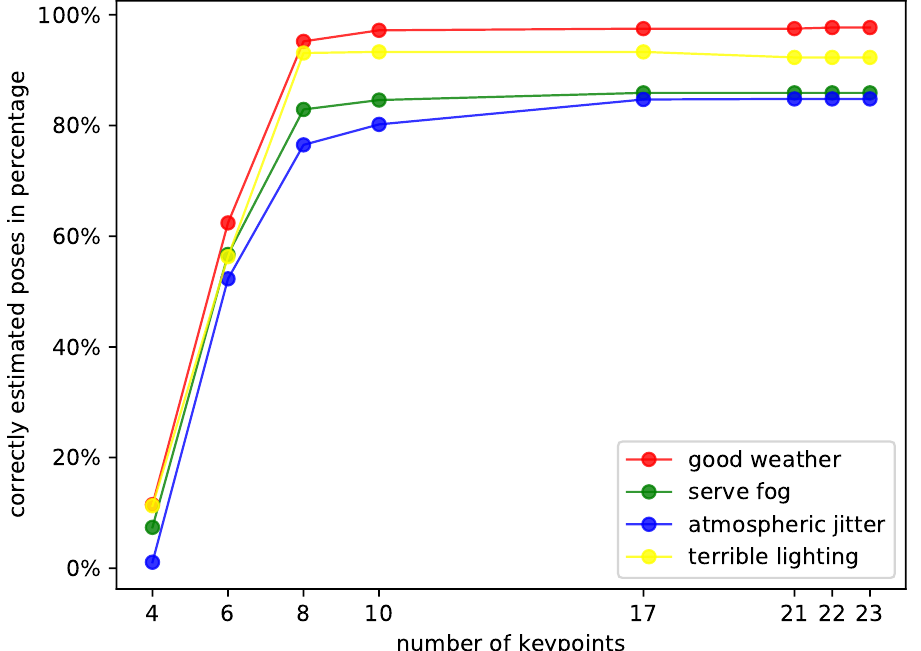
Figure 17. Discussion on different keypoints numbers for pose estimation on the APE dataset. These results are accuracies in terms of the 2D reprojection metric. With the increase of the keypoints’ number the accuracy of pose estimation